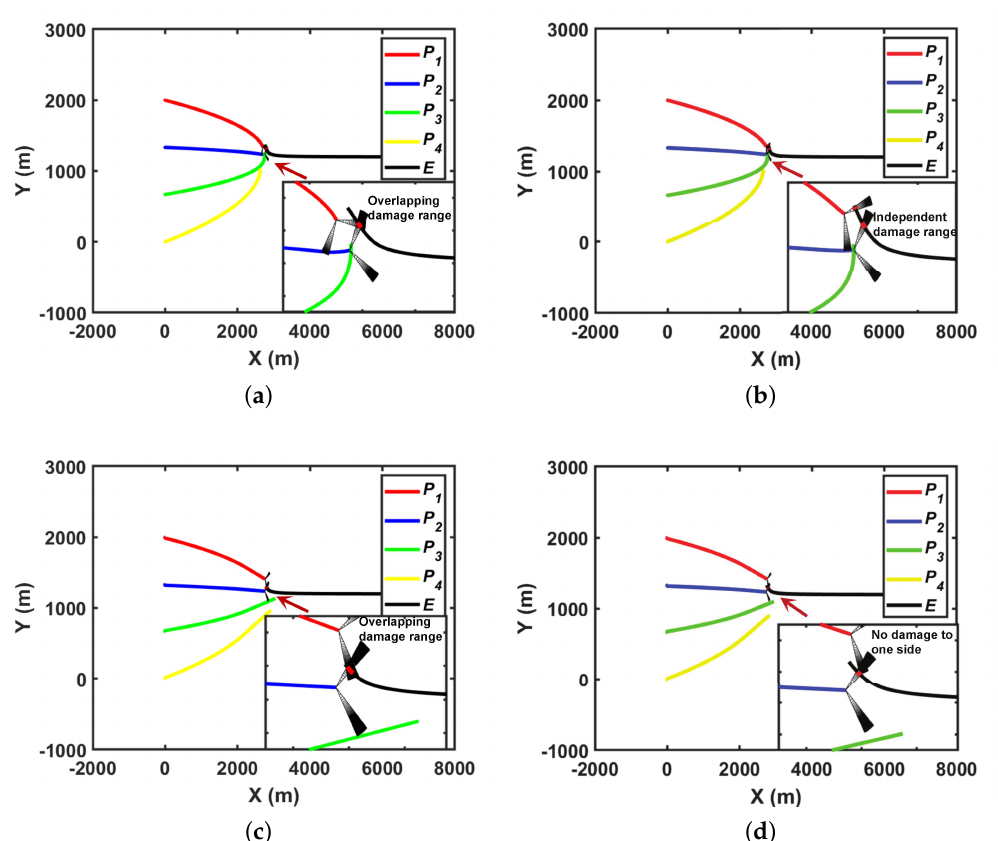
Figure 7. Trajectory and damage range of pursuers/evader: ( a ) proposed strategy; ( b ) strategy from the literature [13]; ( c ) strategy of Equation (24) with high precision; and ( d ) strategy of Equation (24) with low